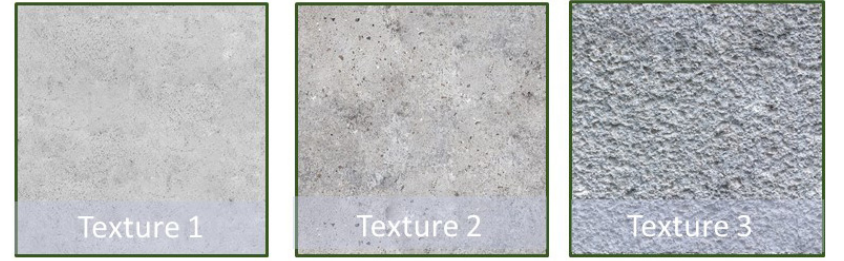
Figure 4. Di ff erent concrete textures in the training dataset.